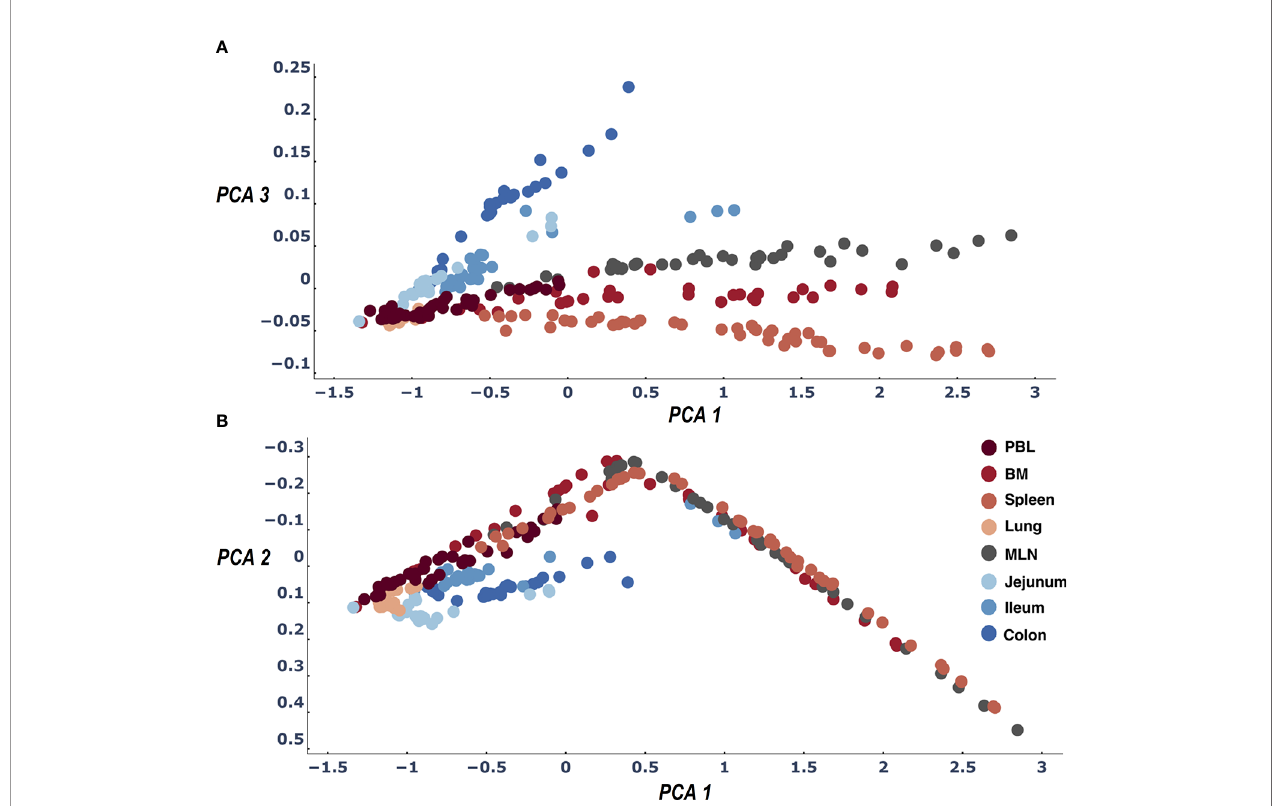
FIGURE 3 | Three dimensions of the PCA of the LPA signature differences across all sample pairs: PCA1 and PCA2 (B) and PCA1 and PCA3 (A) . The fi rst three dimensions of the PCA account for>95% of the variance. When we color samples by their tissue a clear pattern emerges differentiating between all tissues. We fi nd the expected difference between gut and blood tissues (21) and in addition observe that the samples of the lymphatic tissues (Spleen, MLN, BM) are differentiated by their clone size LPA